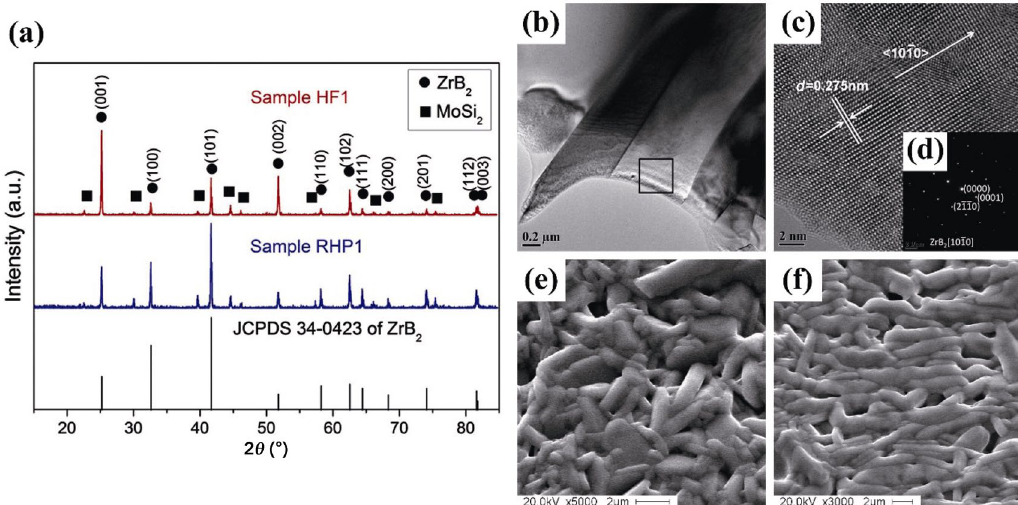
Fig. 34 XRD, TEM, and SEM analysis of textured ZrB 2 –20 vol% MoSi 2 composites prepared by RHP and HF: (a) XRD patterns of specimen surfaces perpendicular to the pressure direction; (b, c, d) TEM image, HRTEM image, and selected-area electron diffraction pattern of ZrB 2 platelet grains, respectively; (e, f) SEM images of polished surface parallel to the pressure direction for sample RHP1 and HF1, respectively. Reproduced with permission from Ref. [250], © Acta Materialia Inc.